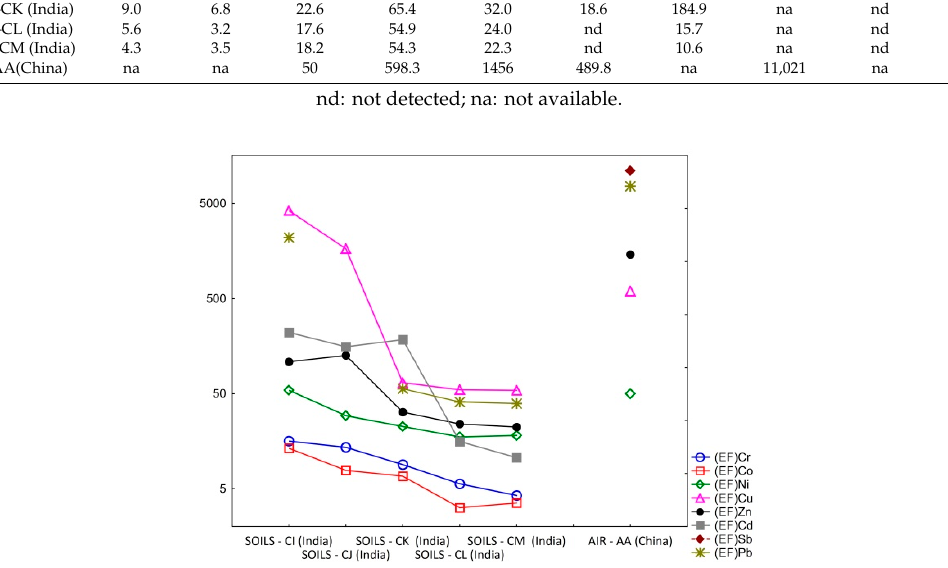
Figure 3. Enrichment factors for trace elements of soils and aerosols suggesting a huge contribution from anthropogenic sources.